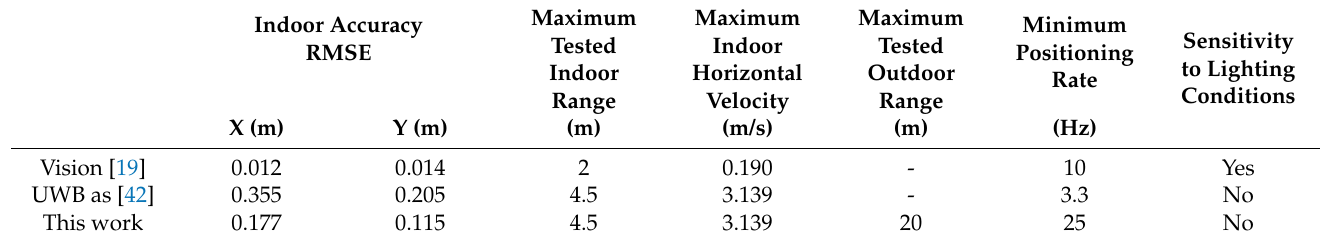
Table 10. Comparison with state of art the